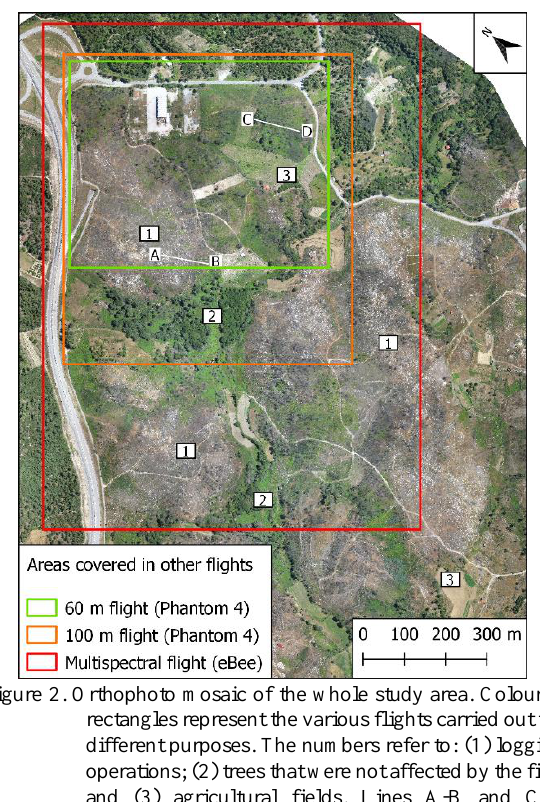
Figure 4. Altitude (a and b) and height (c and d) from two profile lines of DSMs and CHMs of the three RGB